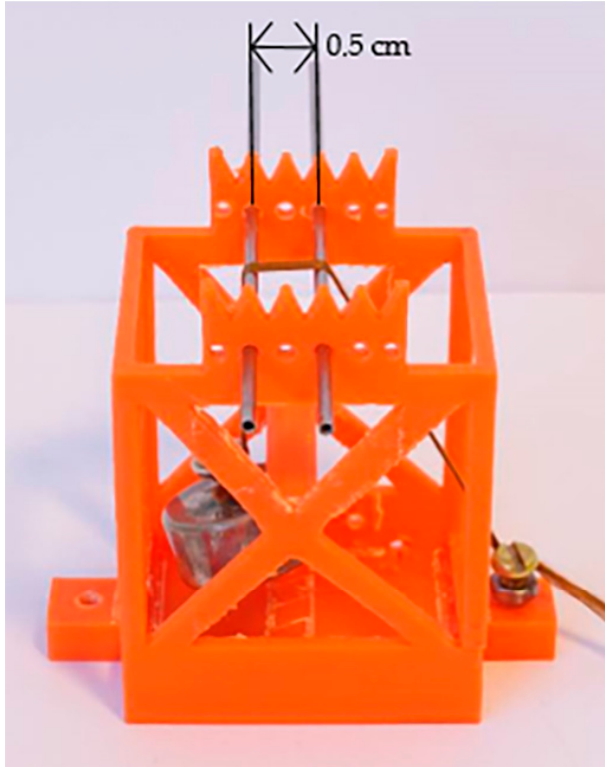
Figure 1. System for electrical characterization of